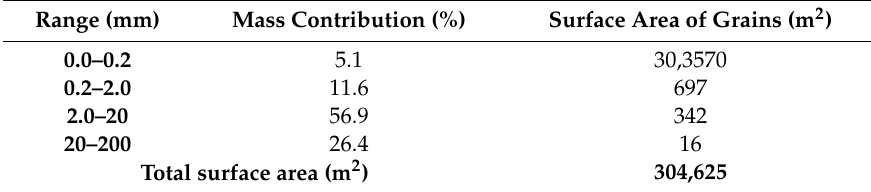
Figure 6. Particle size distributions from the furthest and nearest outburst material. Table 3. Mean contribution of grain size classes to the mass of outburst material and the newly formed